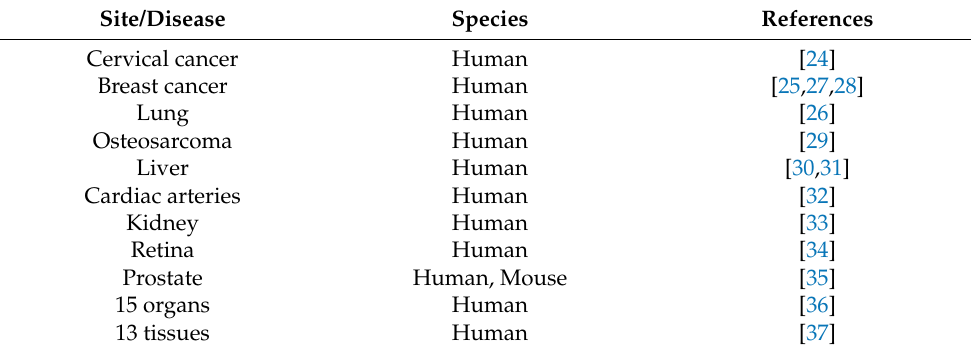
Table 1. A compilation of the summarized single-cell atlases and databases.